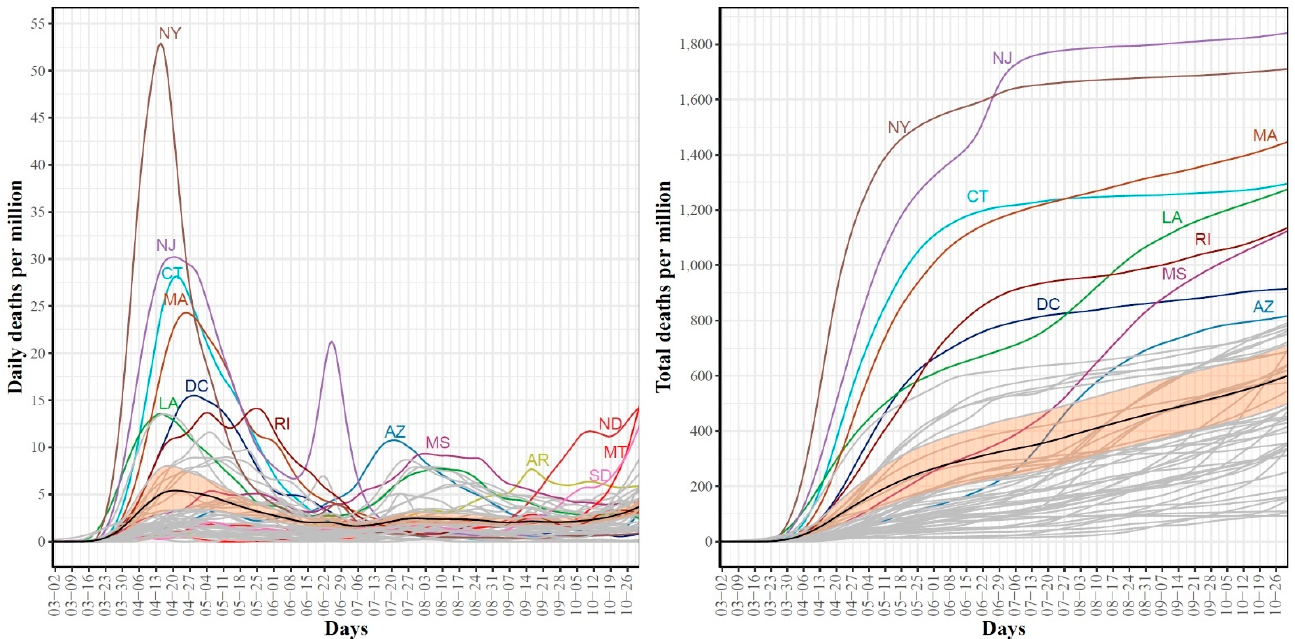
Figure 2. Trajectories for COVID-19 daily ( left ) and total ( right ) per million death cases for the 51 US states. The mean curve is highlighted in black and the orange ribbon corresponds to the 95% confidence band.